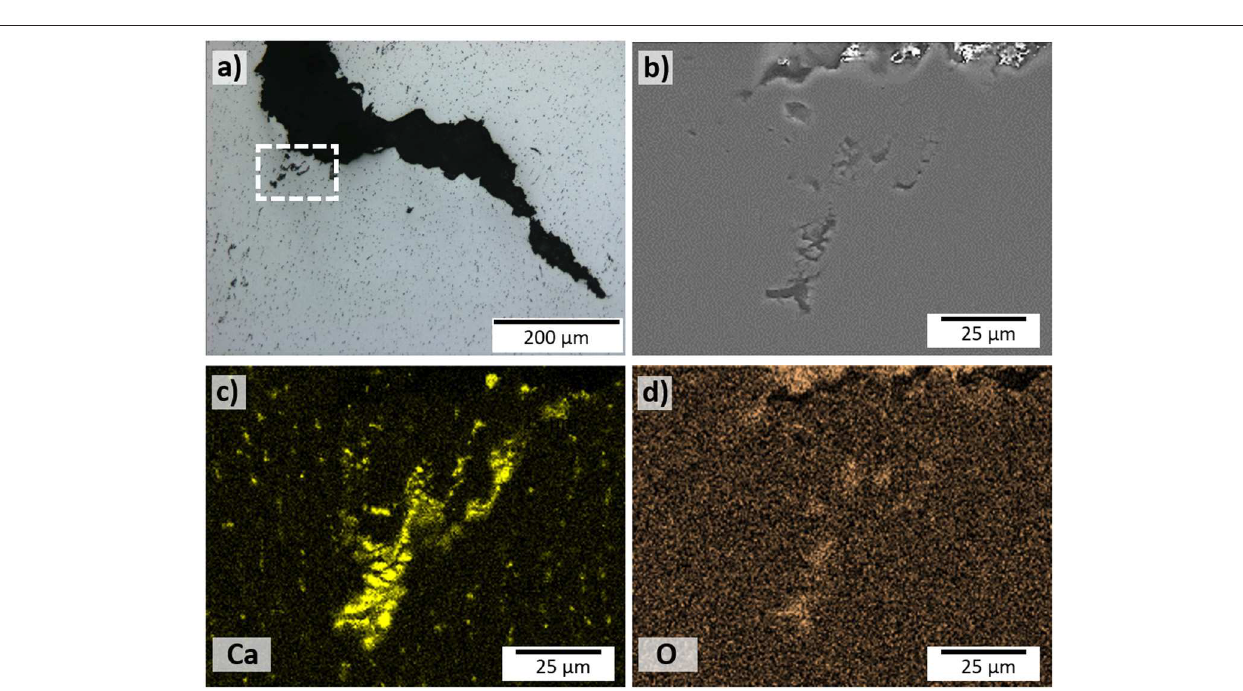
FIGURE 6 | (a) Optical micrograph showing a close up near the fracture front indicated by the white arrow in Figure 5b , (b) SEM micrograph showing an enlarged area of interest inscribed in the dashed rectangle in (a) , and EDX chemical element mapping of the same area for (c) calcium and (d) oxygen.